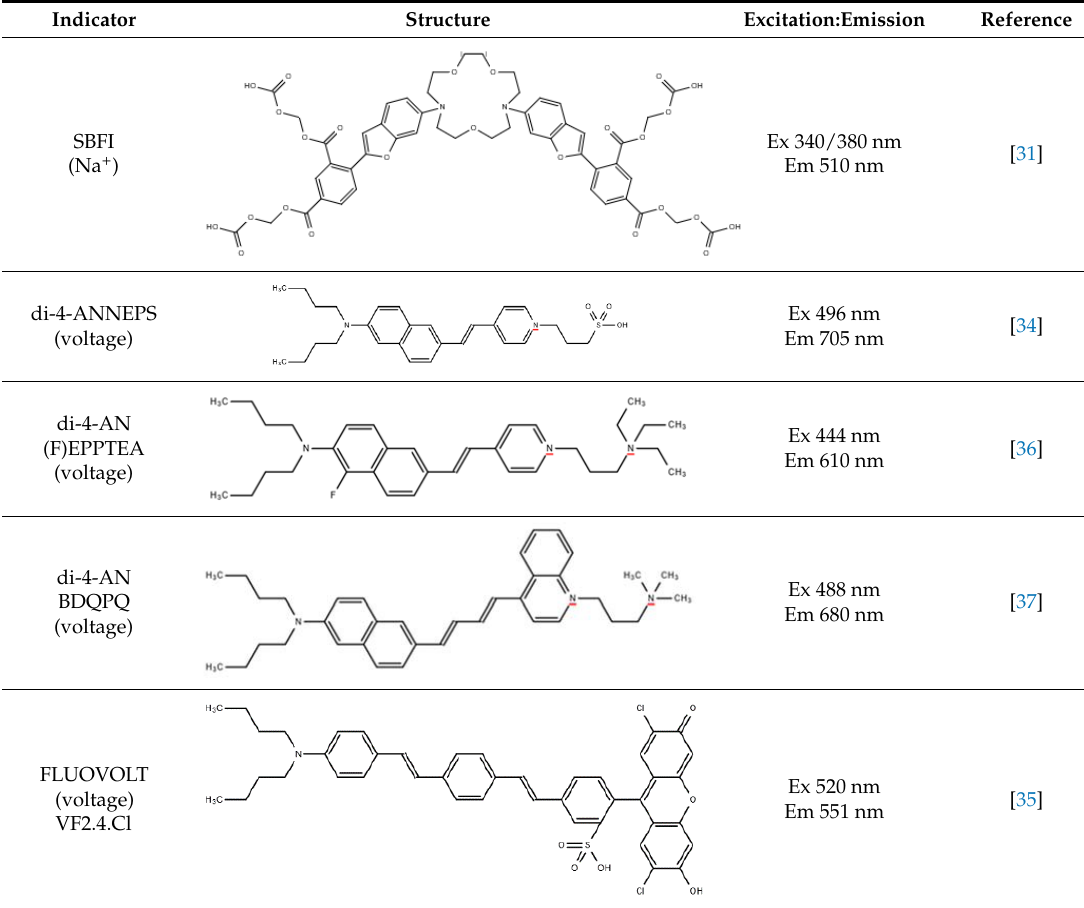
Table 2. A summary of structures and excitation:emission wavelengths of commonly used chemical indicators to investigate cardiac deplolarization.